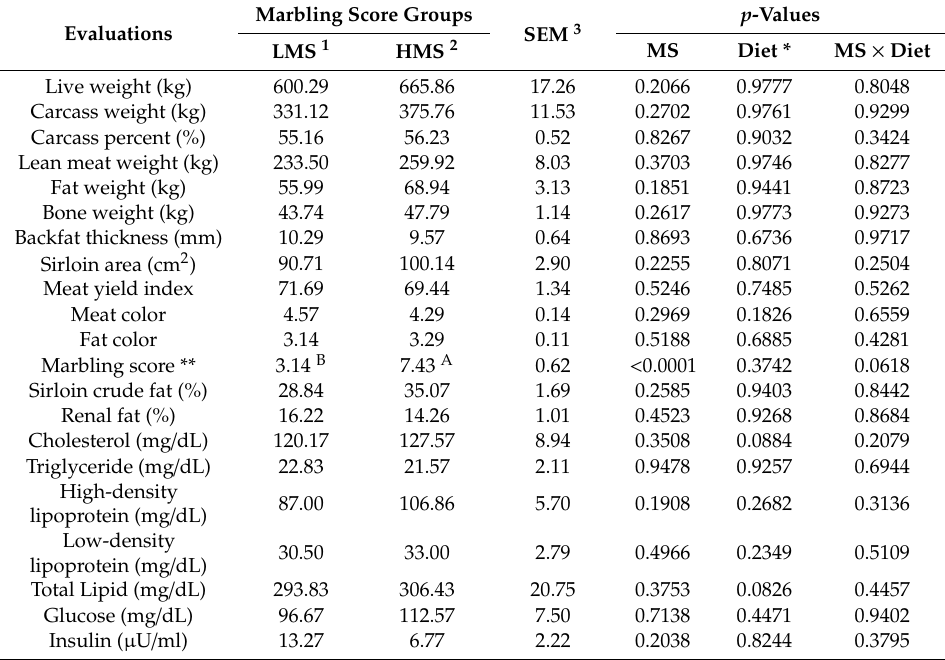
Table 1. Carcass characteristics and blood metabolites of Hanwoo beef cattle between LMS and HMS